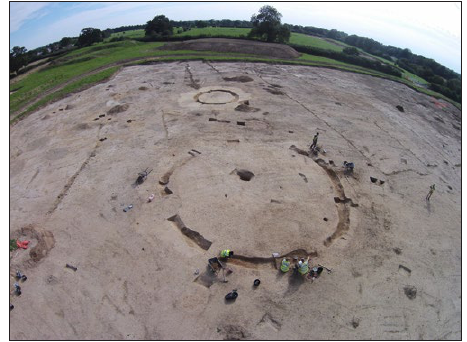
Figure 7: Field work conducted by Archaeol- ogy South East near Angmering, West Sus- sex (Photo: